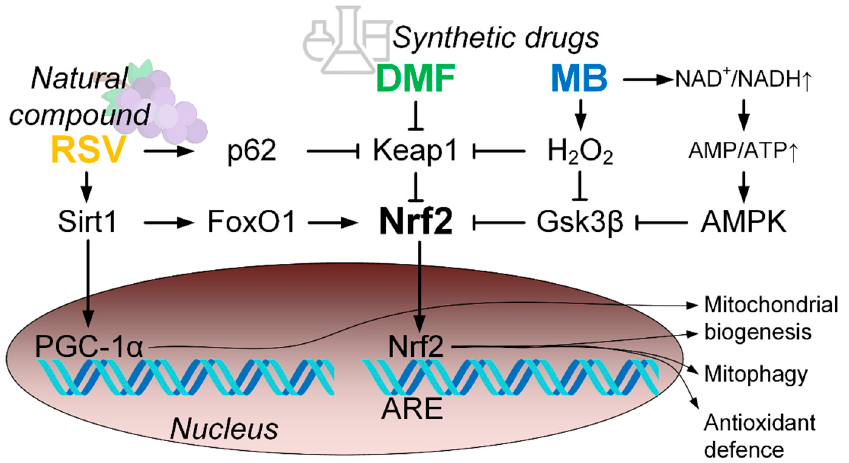
Figure 9. Scheme of the activation of the Nrf2/ARE signal pathway by dimethyl fumarate (DMF); methylene blue (MB); resveratrol (RSV).